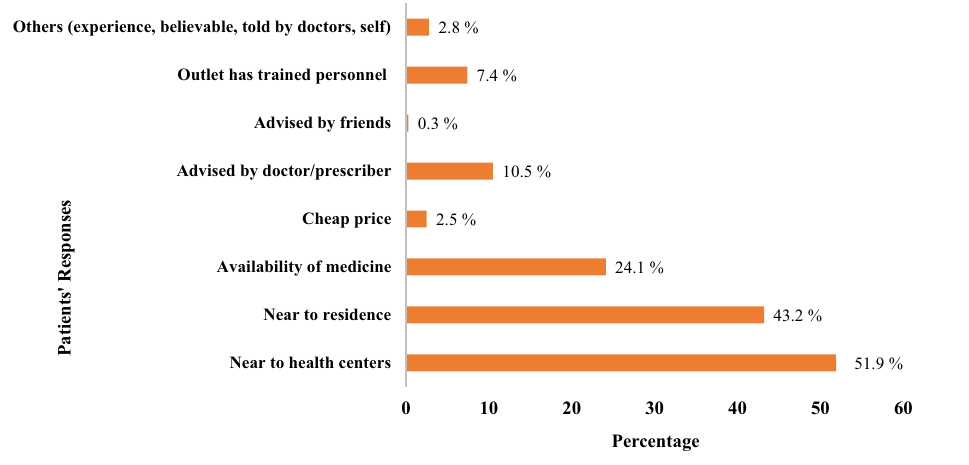
Figure 2. Patient’s responses to buy medicine from particular outlet.